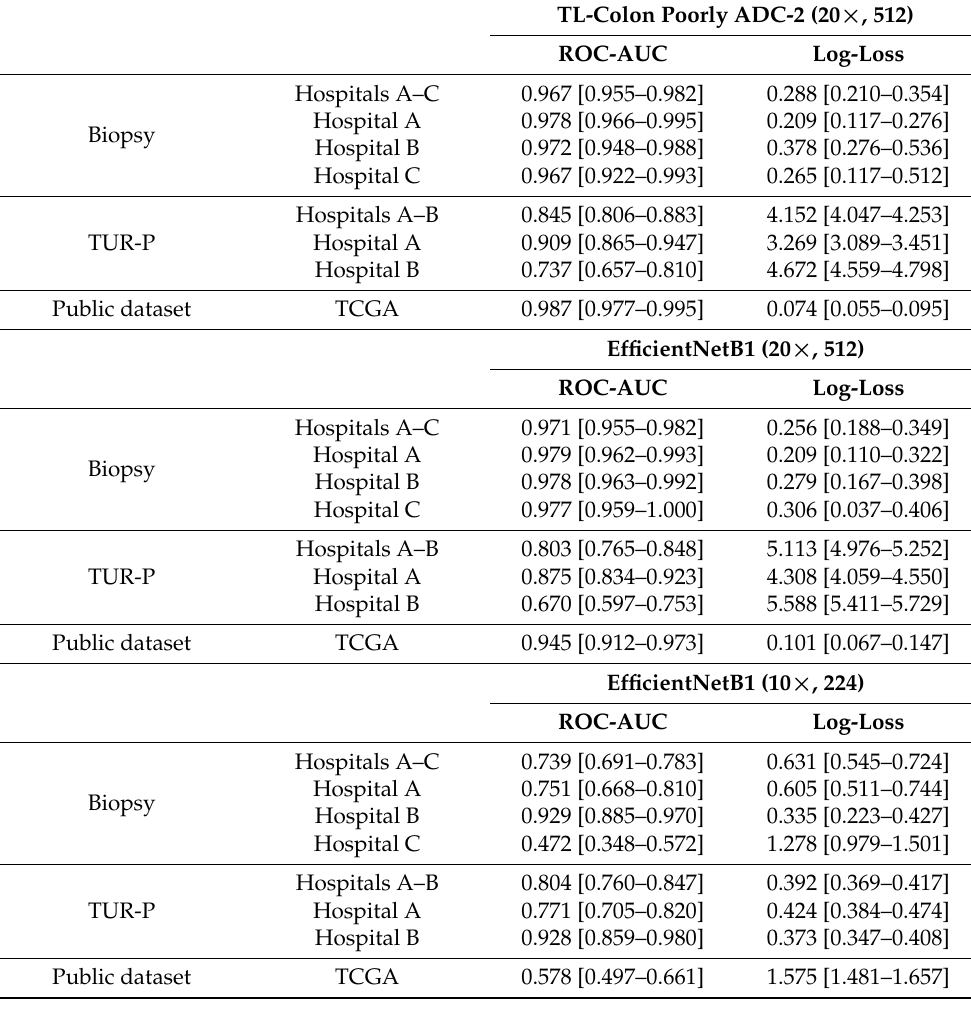
Table 4. ROC-AUC and log loss results of the three different models for prostate adenocarcinoma on the biopsy, TUR-P, and TCGA test